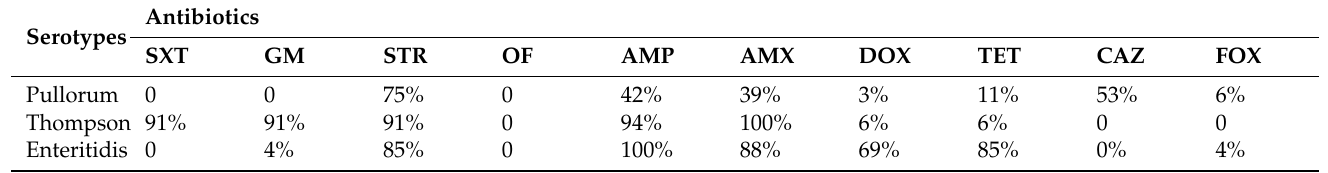
Table 4. Resistance rates of different serovar Salmonella isolates toward 10 antimicrobial agents.